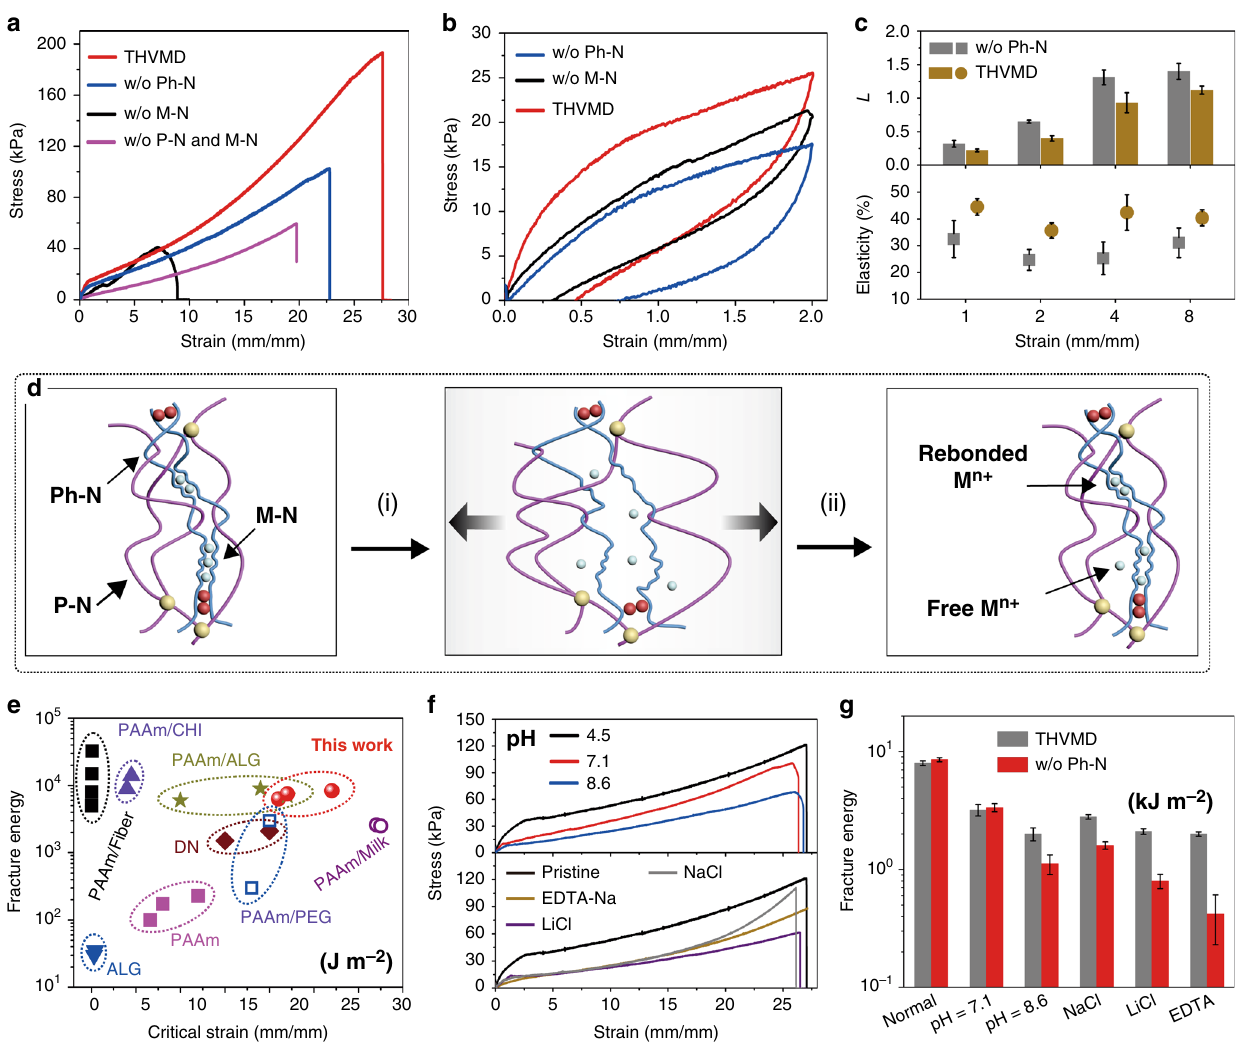
Fig. 3 Mechanical properties of THVMD hydrogels under various conditions. a Stress-strain curves of various hydrogels. b Three types of hydrogels were stretched to a strain of 2 and were then released. c The plastic deformation (L) and elasticity of tough hydrogels and hydrogels without Ph – N networks at different strains. Error bars are de fi ned as S.D. ( n = 3 independent samples). d The proposed mechanism of (i) stretching and (ii)